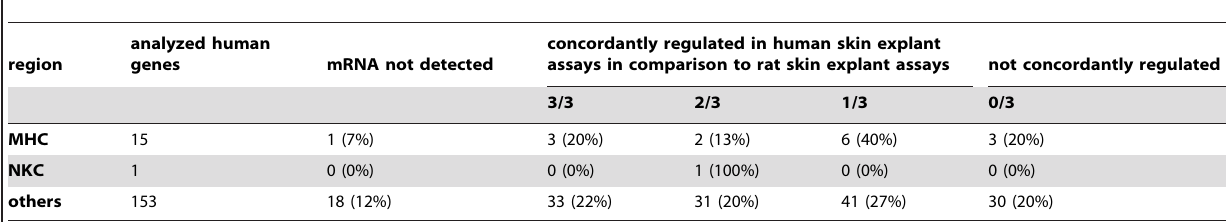
Table 4. Proportion of concordantly regulated in MHC, NKC, and genes encoded in other regions in human skin explant assays in comparison to rat skin explant assays.